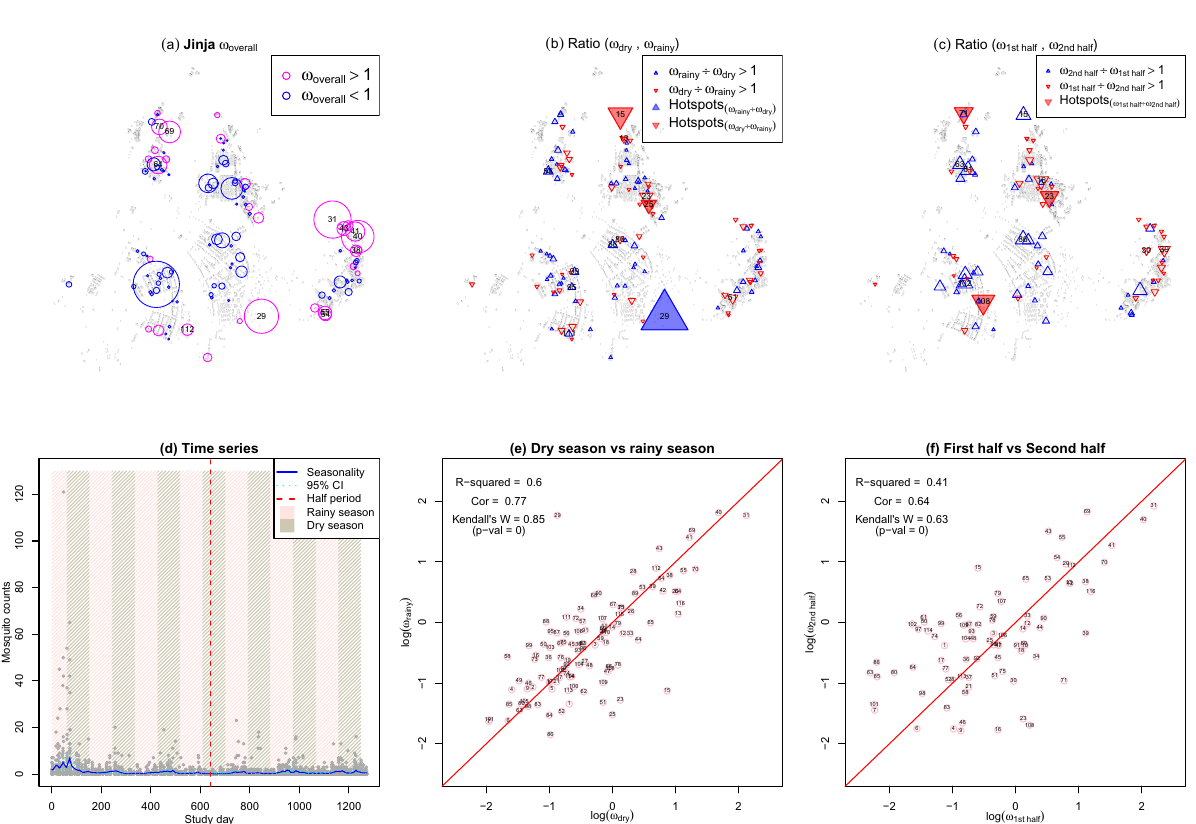
Figure 3. Jinja ( a ): Household biting propensities for the entire duration of surveillance. Pink circles denote households with ω > 1 with overall the size of the circles showing the magnitude of ω ; blue circles denote households with ω < 1 with the size of the circles showing overall overall the magnitude of 1/(3× ω ) to make their sizes comparable to the pink circles; 10% of households with the largest ω are labelled. The overall overall largest pink circle indicates a household with the largest ω while the largest blue circle indicates a household with the smallest ω . overall overall Households with the largest ω include HH31, HH29, and HH40. Grey dots in the background denote all enumerated households at overall Walukuba subcounty, Jinja District. ( b ) Ratios of household biting propensities during dry ( ω ) and rainy seasons ( ω ). Each plotted upward dry rainy pointing blue triangle represents a household with a larger ω during rainy season compared to dry season; a blue filled triangle denotes a hotspot for the ratio of ω / ω . Each plotted downward pointing red triangle represents a household with a larger ω during dry season rainy dry compared to rainy season; a red filled triangle denotes a hotspot for the ratio of ω / ω . ( c ) Ratios of household biting propensities in the first dry rainy half period of surveillance ( ω ) and the second half period ( ω ). Each plotted upward pointing blue triangle represents a household 1st half 2nd half with a larger ω in the second half period of surveillance compared to the first half period; there were no hotspots for the ratio of ω / ω . 2nd half 1st half Each plotted downward pointing red triangle represents a household with a larger ω during the first half period of surveillance compared to the second half period; a red filled triangle denotes a hotspot for the ratio of ω / ω . ( d ) Time series of mosquito count data for the entire 1st half 2nd half duration of surveillance, where each grey circle denotes an observation of a household. The blue solid line denotes the estimated seasonal signal and cyan dashed lines denote the 95% Bayesian credible interval for the seasonal signal. The red vertical dashed line denotes the cut-off for the first half and the second half periods. Rainy season is highlighted in pink and dry season is highlighted in light green. A weak seasonal signal was observed in Jinja. ( e ) Scatter plot of log( ω ) and log( ω ) along with measures of R 2 , correlation, and Kendall’s W . For dry rainy ease of interpretation, we plotted the ω on the logarithmic scale. The log transformation also preserved the order of the observations while making outliers less extreme. ( f ) Scatter plot of log( ω ) and log( ω ) along with measures of R 2 , correlation, and Kendall’s 1st half 2nd half